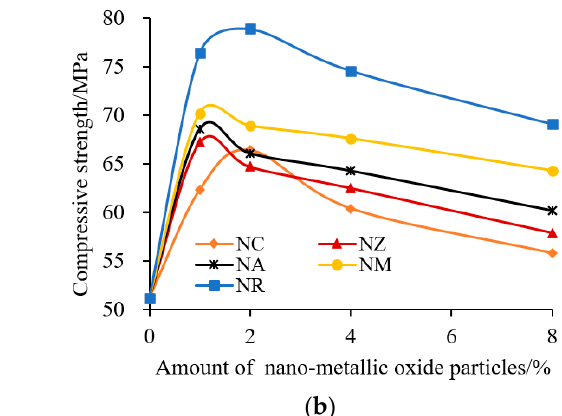
Figure 2. Compressive strength of cement mortar with nano-metallic oxide particles: (a) 28 days; (b) 730 days. ( b ) 730